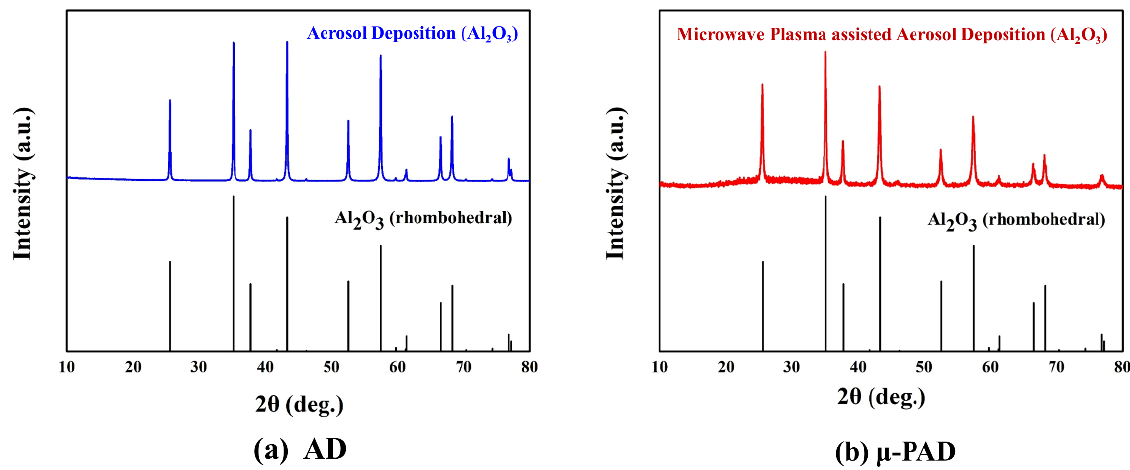
Figure 6. XRD spectra of Al 2 O 3 raw powder and coating film: ( a ) coating by AD, and ( b ) μ -PAD.